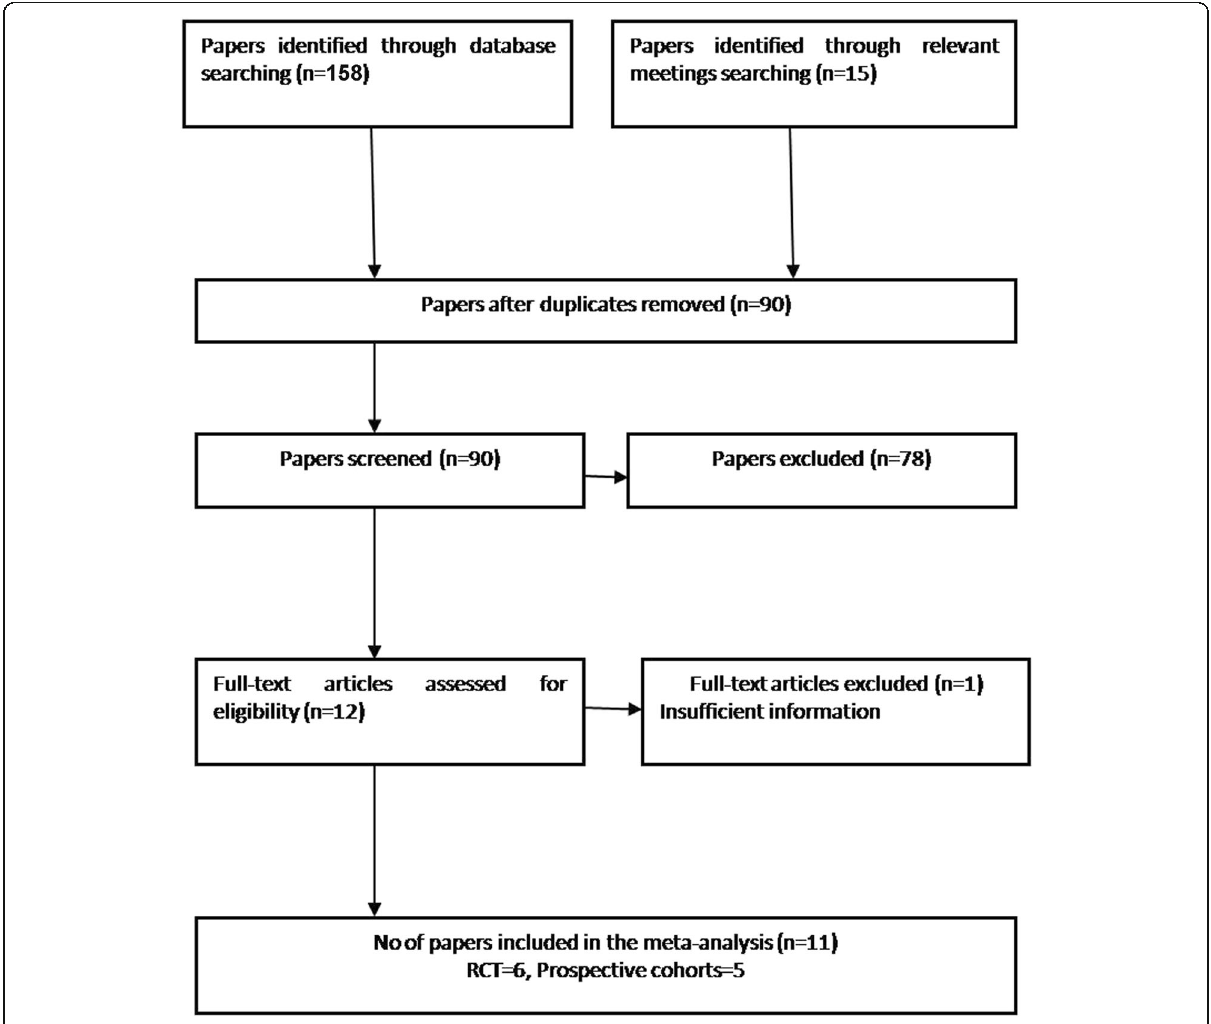
Fig. 1 Study flow diagram of the system